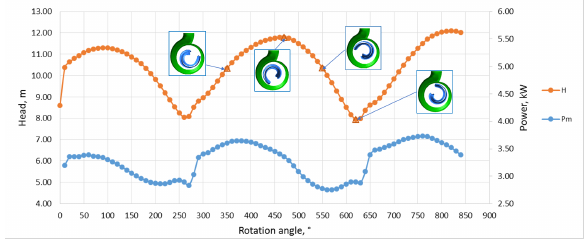
Figure 5: The head and power fluctuation in a function of the blade